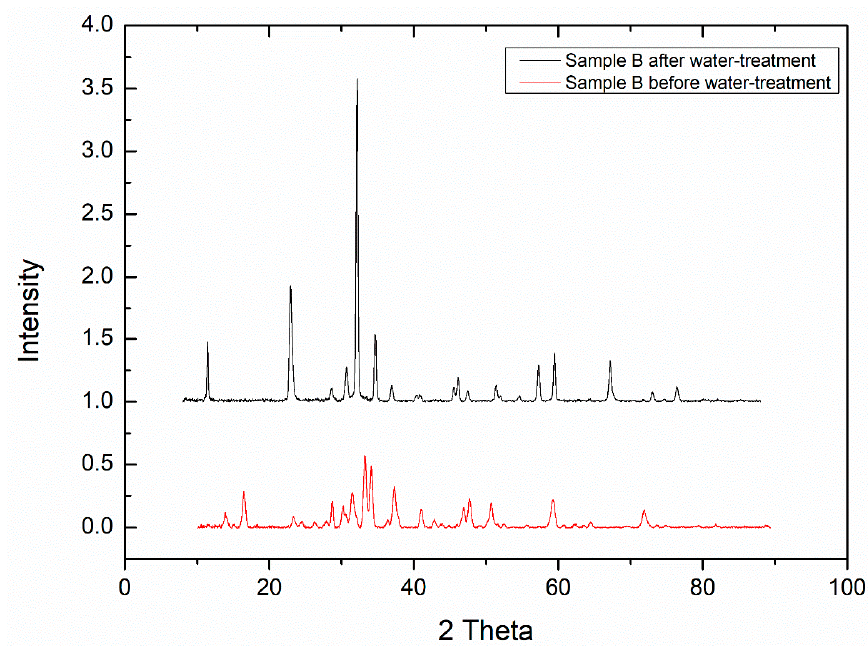
Figure 4. XRD results for sample B (before and after water-treatment).